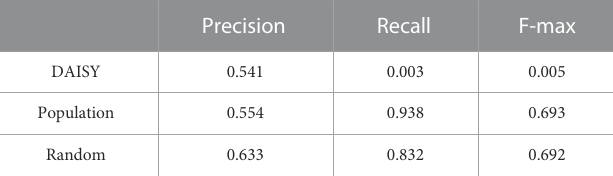
TABLE 1 Performance comparison between population-based methods and a random model. The evaluation is under leave-gene-combination-out setting in K562 cell line. The random model uses randomly generated network and randomly generated gene features as